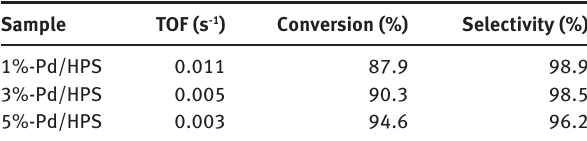
Table 2 Results of catalytic testing.